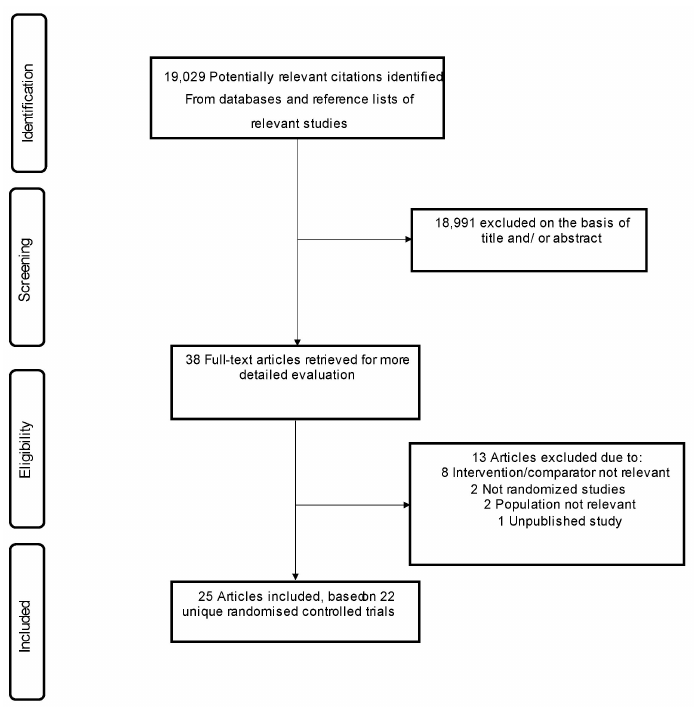
Figure 1. PRISMA flow